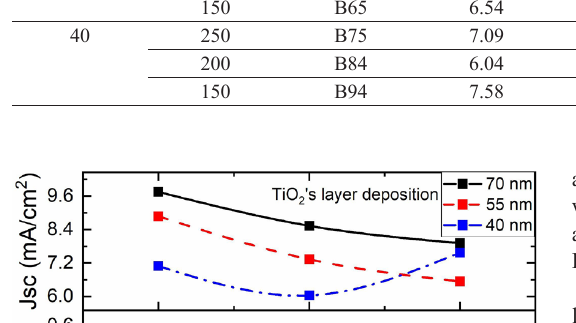
Table 3. Experiment B and the variation of their parameters in cells with the configuration FTO/TiO TiO (nm) AL (nm) 2